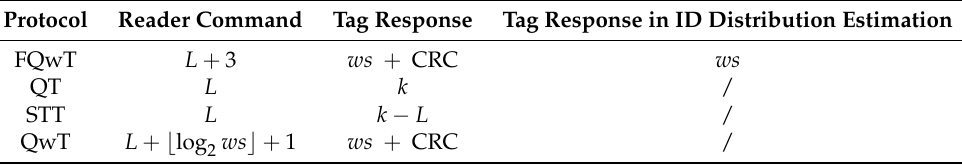
Table 2. Parameters used in